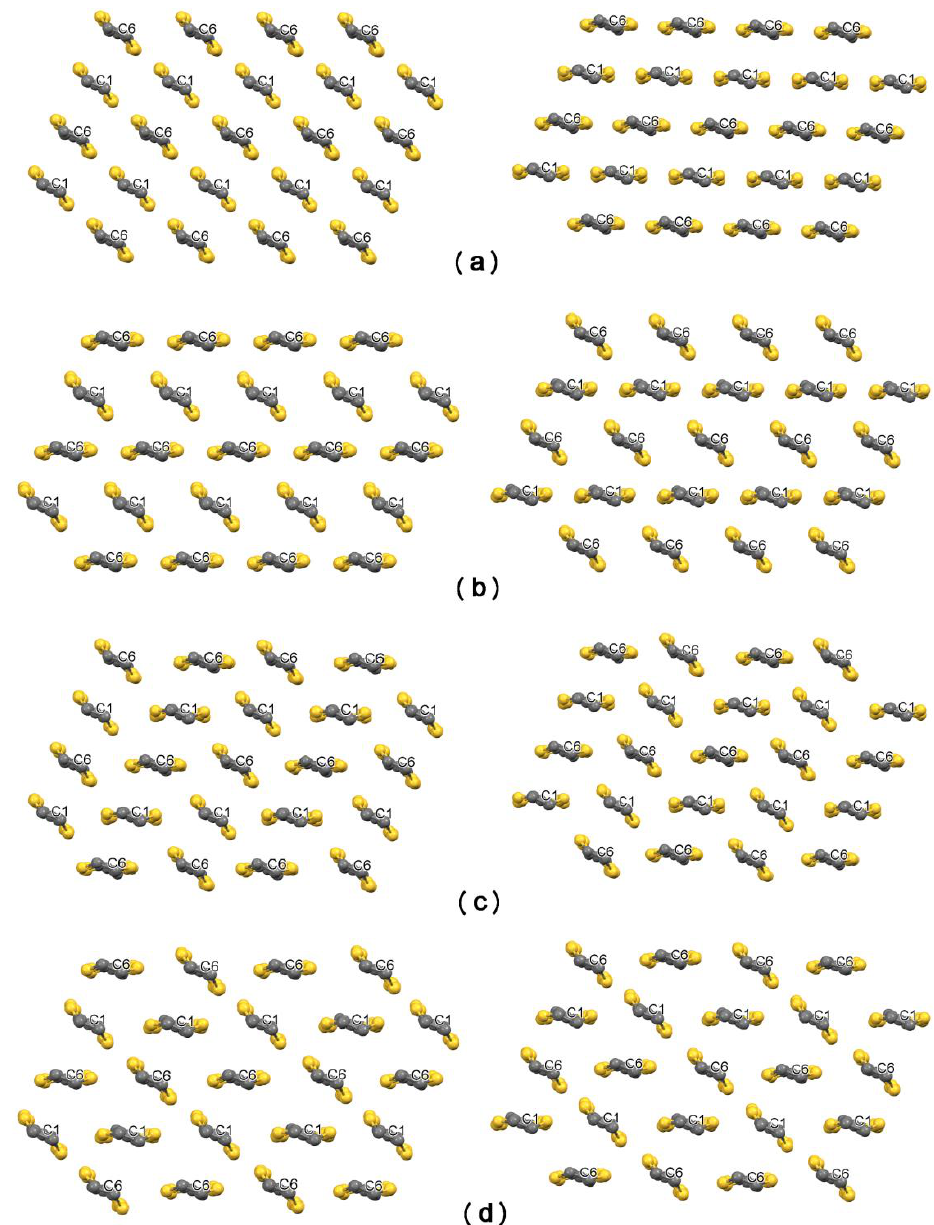
Figure 4. Options for the structure of the organic radical cation layer in 1. For each of cases ( a – d ) the left and right panels show two variants of the structure of the BEDT-TTF layer, the superposition of which could lead to the structure shown in Figure